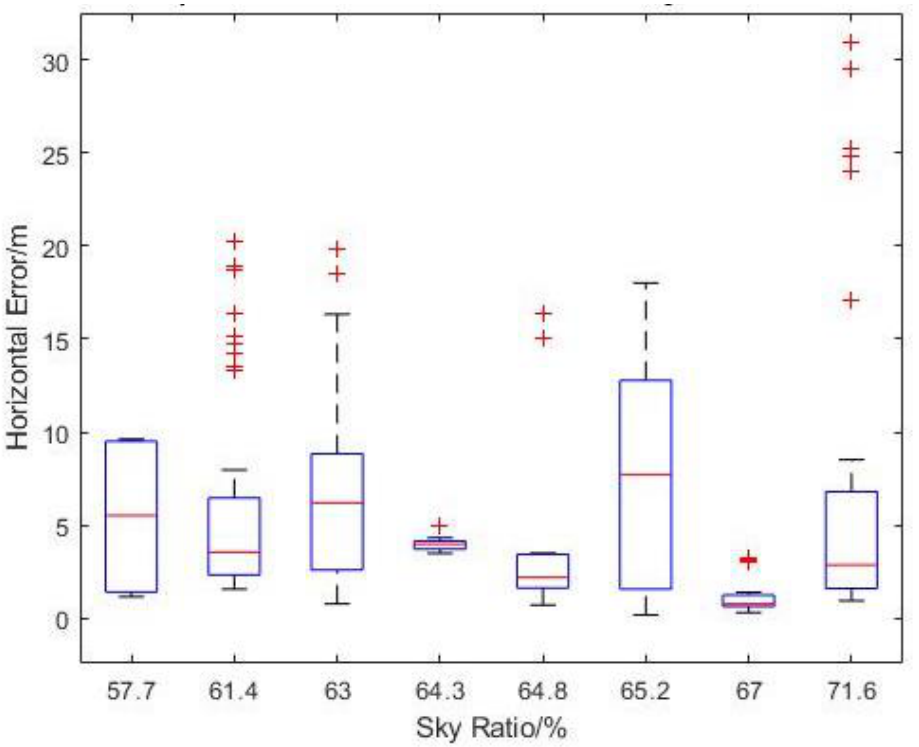
Figure 20. Boxplot of Measured Horizontal Error vs. Sky Ratio at N2.1.